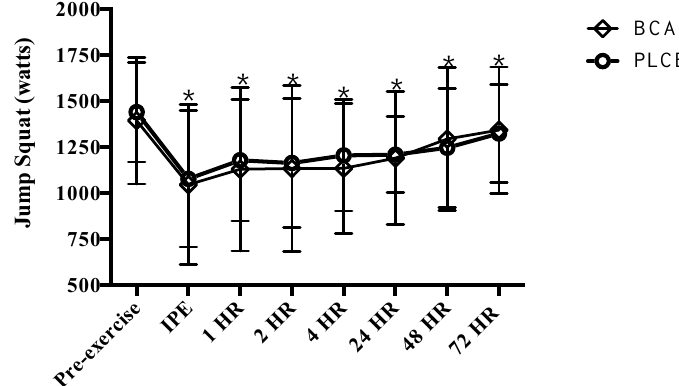
Figure 4. Mean ( ± standard deviation) peak power output (watts) pre-eccentric exercise, immediate post (IPE), 1, 2, 4, 24, 48 and 72 hours (HR) for resistance trained men supplementing with branched-chain amino acids (BCAA) or placebo (PLCB) ( n = 20). * = significantly different from pre-exercise ( p < 0.05) for both BCAA and PLCB.